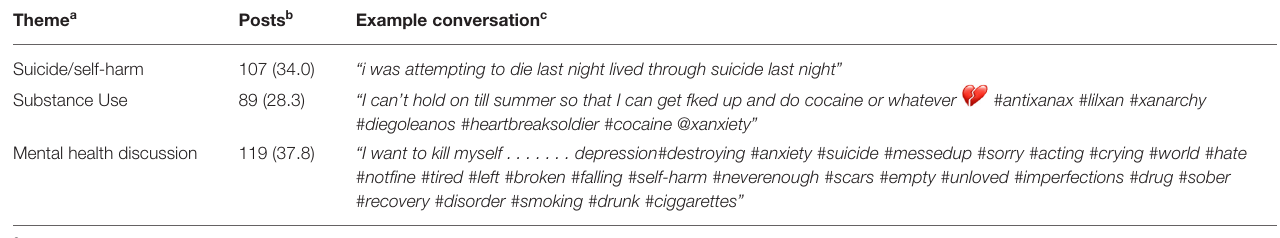
TABLE 1 | Number of posts related to substance use behavior, suicide and/or self-harm, other mental health discussions (text of posts have been modified to de-identify from user, no user information reported). Theme a Posts b